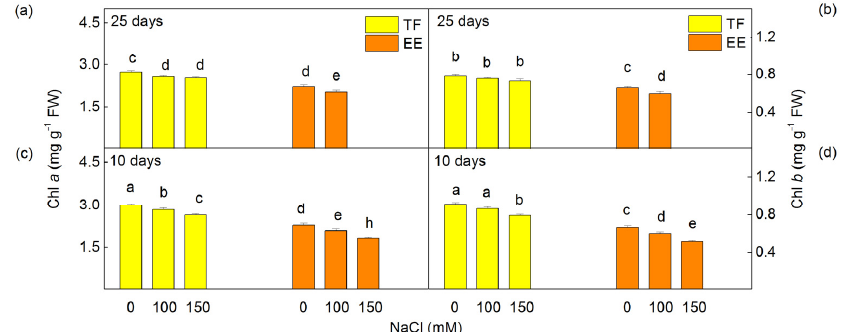
Figure 1. Effect of different concentrations of NaCl on the chlorophyll content of Paulownia tomentosa x fortunei (TF) and Paulownia elongata x elongata (EE) leaves. The plants were treated for 10 ( c , d ) and 25 days ( a , b ). Mean values (±SE) for a given parameter marked with different letters are statistically significant at p < 0.05.